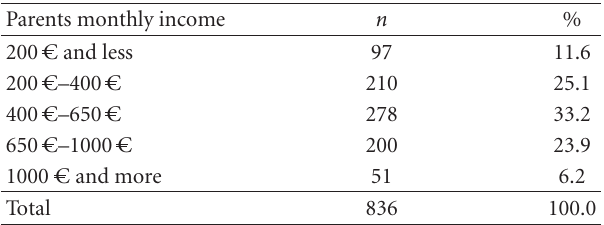
Table 1: Parental monthly income.